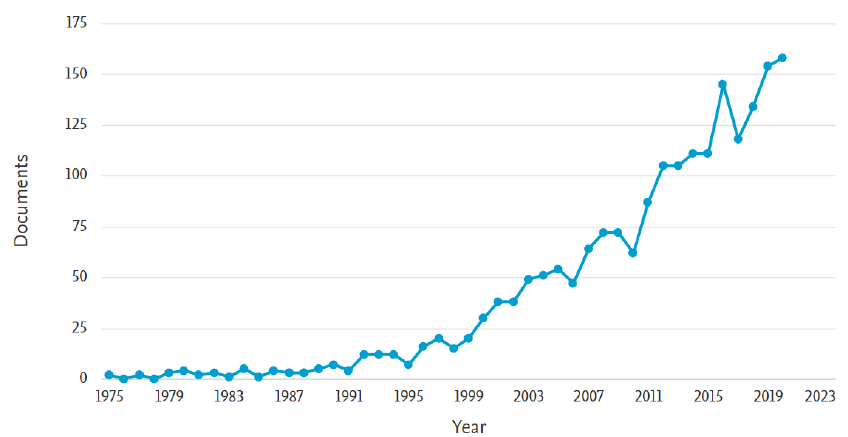
Figure 1. Number of documents tagging “coral mapping” or “coral remote sensing” in the Scopus database over the last 50